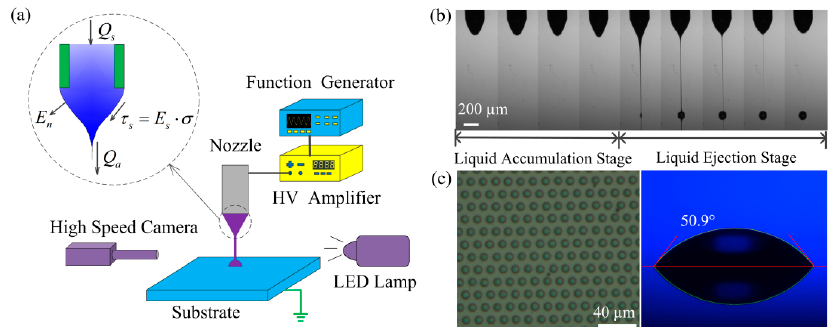
Figure 1. The schematic of e-jet printing: ( a ) the schematic of the e-jet printing setup; ( b ) the ejection process of e-jet printing; ( c ) the printed dot array on the substrate, where the right image represents the contact angle of the droplet with the substrate.